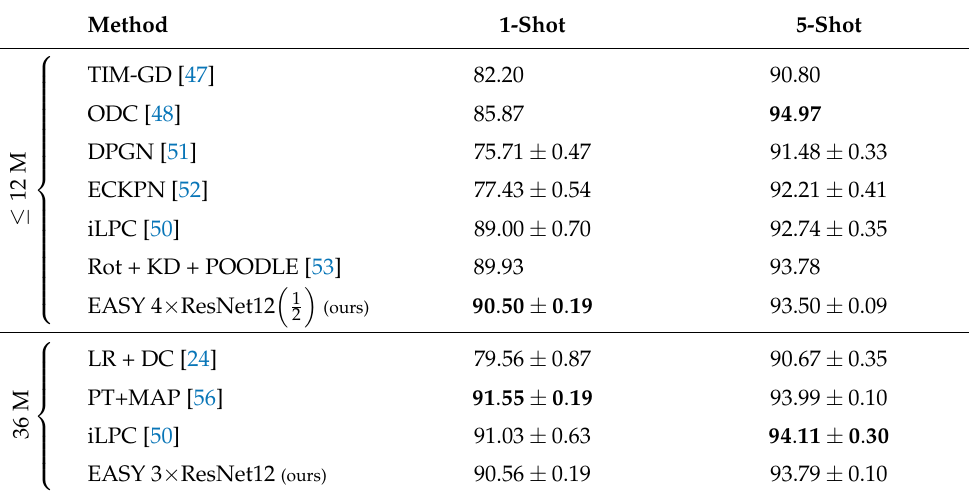
Table 7. The 1-shot and 5-shot accuracy of state-of-the-art methods and the proposed solution on CUB-FS in the transductive setting.